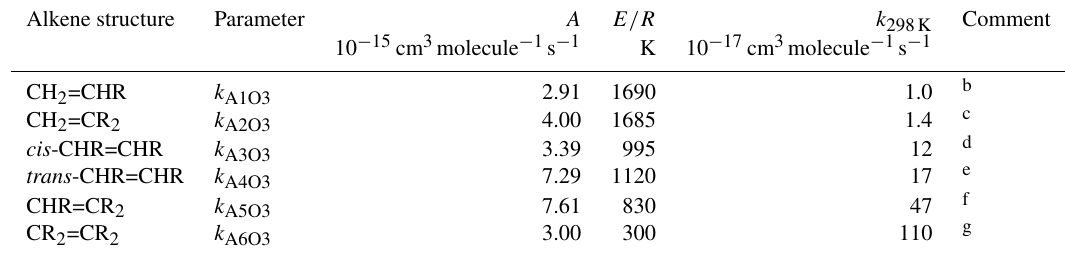
Table 1. Arrhenius parameters ( k = A exp ( − (E/R)/T ) ) for the reference rate coefficients for O 3 addition to generic monoalkenes containing linear alkyl groups (i.e. R can be -CH 3 or -CH 2 R (cid:48) ), and the rate coefficient values at 298K a .